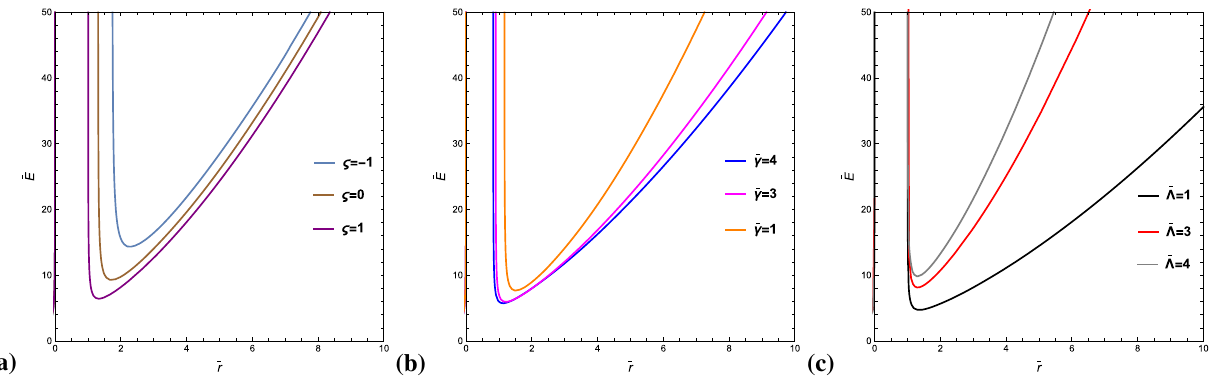
Fig. 2 The graphs show the angular velocity Ω to ¯ r for the particles moving around the black hole and make the thin accretion disk. a Different values of ¯ γ with considering ¯ Λ = 2. b Different values of ¯ Λ with considering ¯ γ = 2